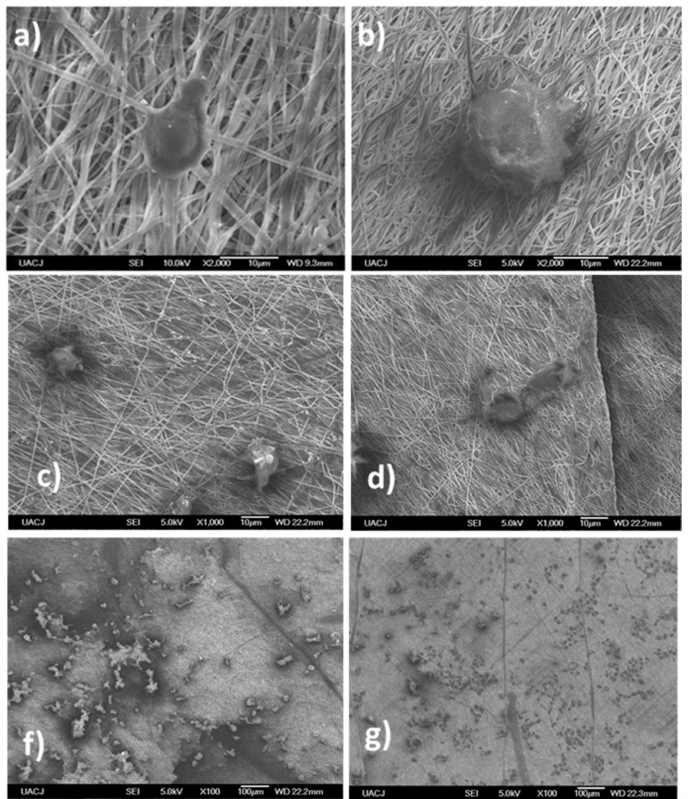
Figure 8. Evaluation of the integration and anchoring of 3T3 Mouse cells seeded on nanofibers on day 14 after wound at different magnifications for aminated nanofibers: ( a ) 100 × , ( c ) 1000 × , ( f ) 2000 × ; and aminated nanofibers with EGF: ( b ) 100 × , ( d ) 1000 × , ( g ) 2000 × .